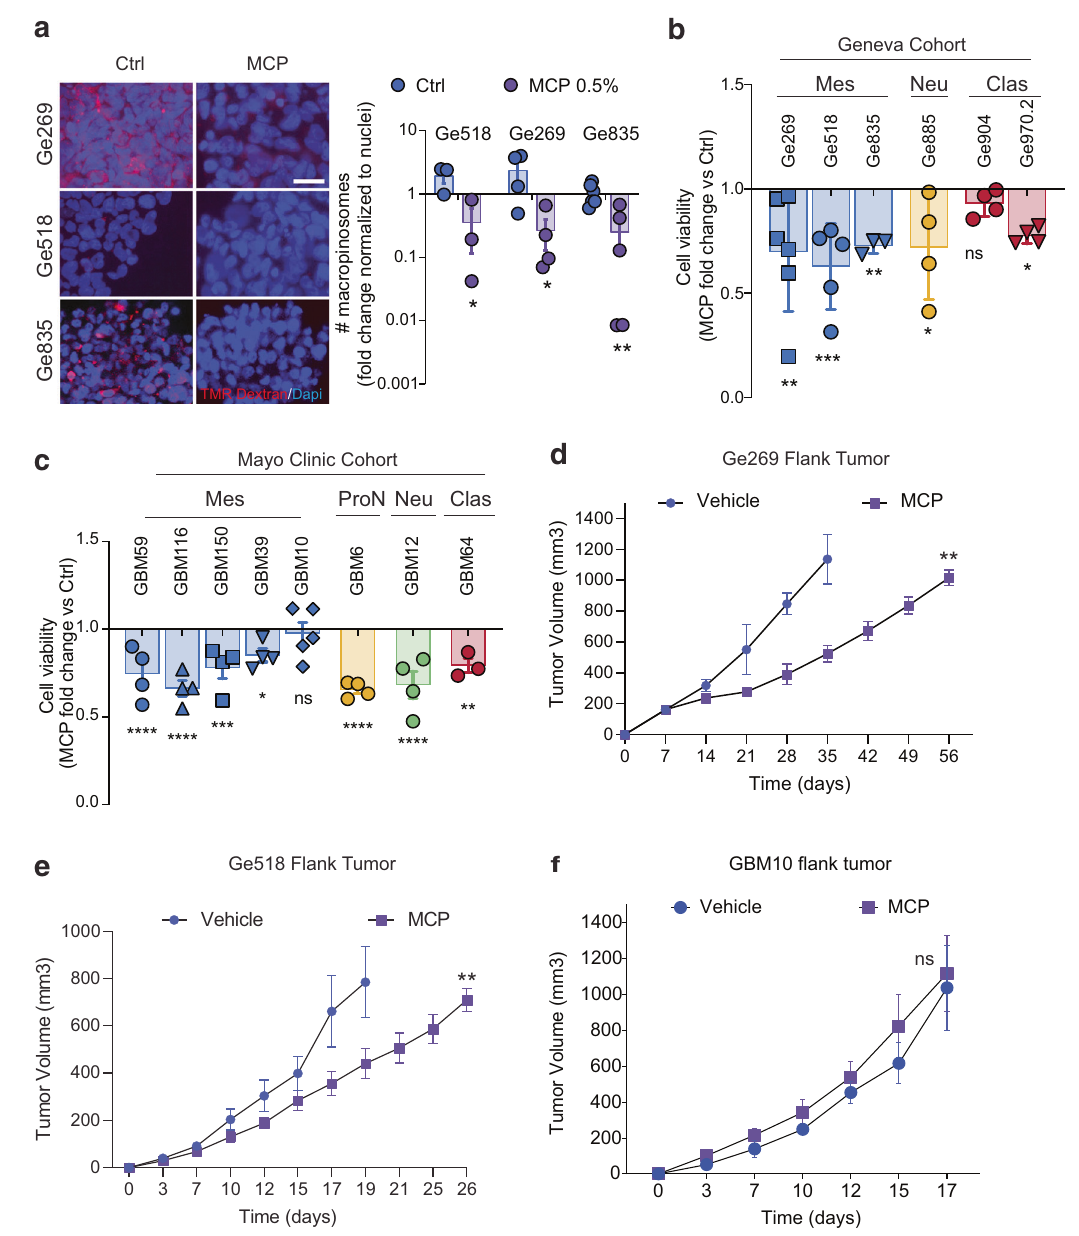
Fig. 7 MCP disrupts Gal-3/RAB10 binding and inhibits macropinocytosis-mediated GSC survival. a Macropinocytosis uptake assay using TMR-dextran in GSCs. Histograms represent the fold change of macropinocytosis activity in Ge518, Ge269, and Ge835 treated with MCP compared to their control ( n = 3 – 5). Scale bar, 10 µ m. b Effect of MCP on cell viability measured by CellTiter-Glo in GSCs ( n = 3 – 6). c Effect of MCP on cell viability measured by CellTiter-Glo in GSCs ( n = 3 – 5). d – f Mice were randomized and treated with either vehicle control ( n = 5) or MCP ( n = 5; 1% orally in the drinking water) after injection of Ge269, Ge518, and GBM10 cells, respectively. Data are represented as mean ± SEM (* p < 0.05, ** p < 0.01, and *** p < 0.001), two-way ANOVA, Sidak ’ s adjusted p value. ns nonsigni fi cant, Ctrl vehicle (H 2